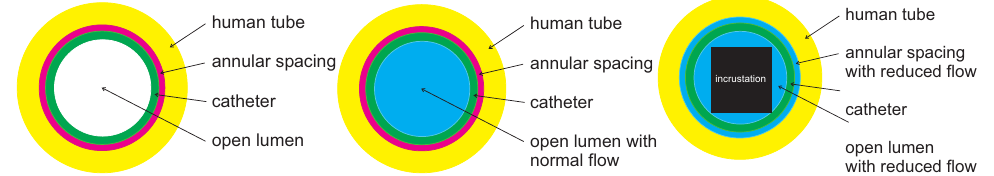
Figure 1. LHS—setup of the catheter in the human tube, middle—normal flow (blue), RHS—flow when blocked